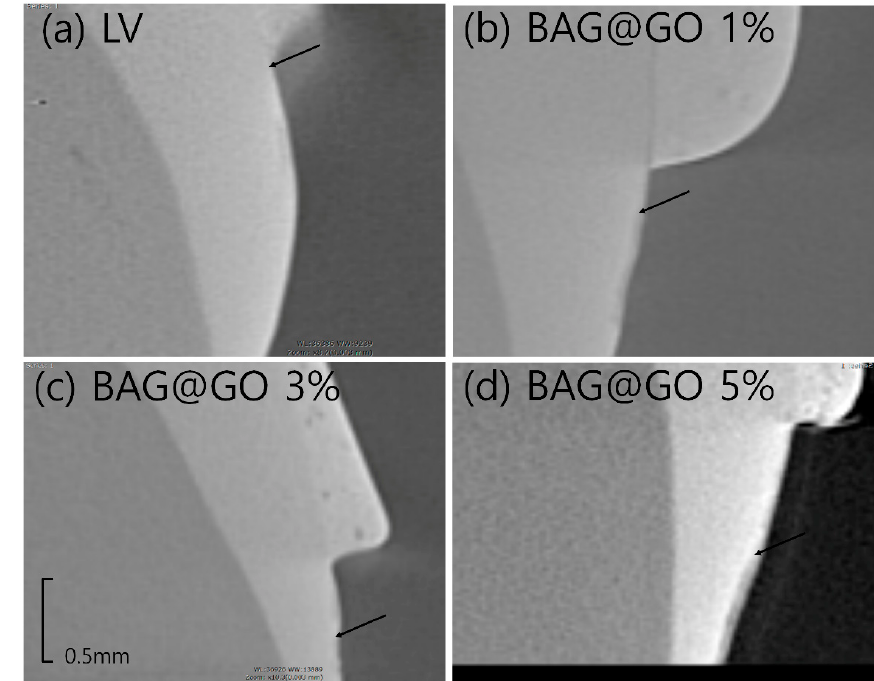
Figure 8. Anti-demineralization point (black arrow) of the LV and BAG@GO orthodontic bonding adhesive via CBCT. ( a ) LV; ( b ) 1 wt.% BAG@GO; ( c ) 3 wt.% BAG@GO; and ( d ) 5 wt.% BAG@GO.